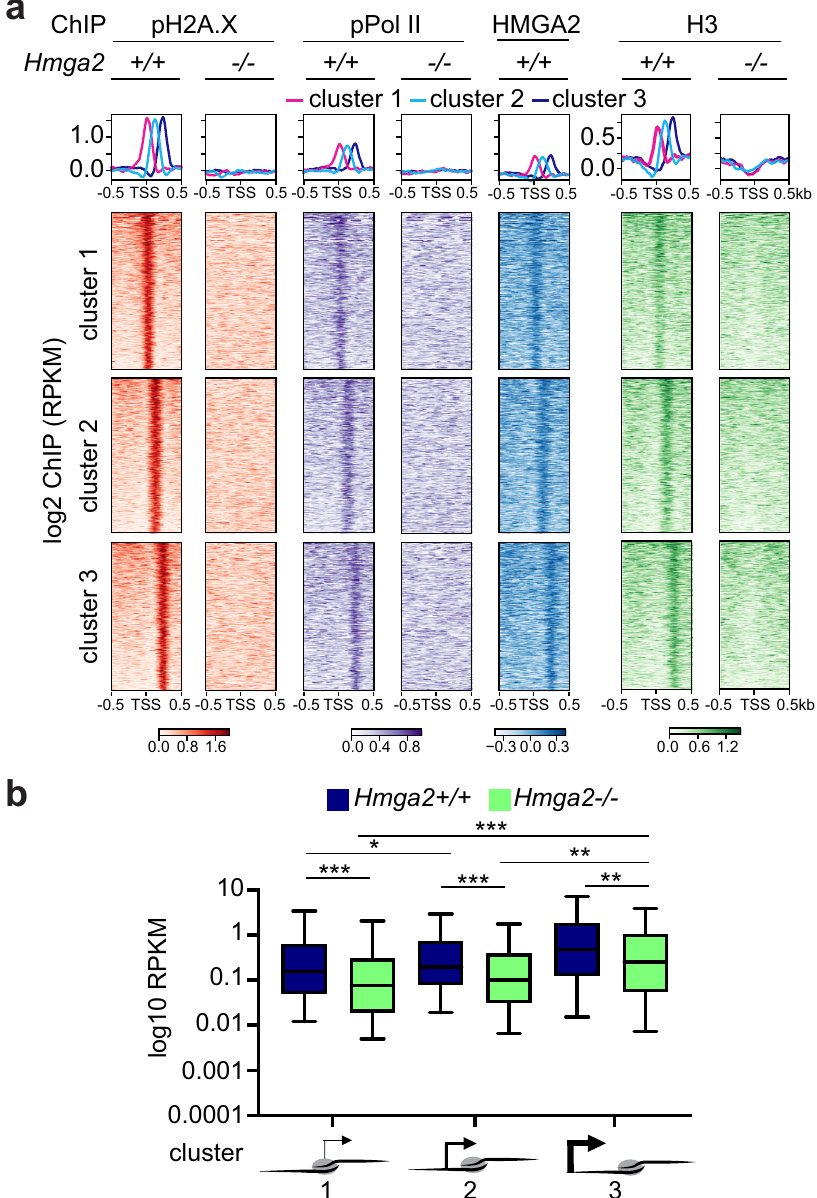
Fig. 3 Position of fi rst nucleosome containing pH2A.X correlates with RNA polymerase II and basal transcription activity in Hmga2-dependent manner. a Aggregate plots (top) and heat maps (bottom) for pPol II, pH2A.X, HMGA2 and H3 enrichment at the TSS ± ≥ kb of the top 15% candidates in Hmga2 + / + and Hmga2 − / − MEF. Three clusters were generated using k -means algorithm. Genes were sorted based on the enrichment of pH2A.X in Hmga2 + / + MEF. b Box plot representing the basal transcription activity (as log2 RPKM) of genes in Hmga2 + / + and Hmga2 − / − MEF. The genes were sorted in three groups based on the position of the fi rst pH2A.X-containing nucleosome 5´ to the TSS. Box plots indicate median (middle line), 25th, 75th percentile (box) and 5th and 95th percentile (whiskers); n = 154 genes in position cluster 1; n = 132 genes in position cluster 2; n = 134 genes in position cluster 3; asterisks, P- values after one-tailed Wilcoxon – Mann – Whitney test, *** P ≤ 0.001; ** P ≤ 0.01; * P ≤ 0.05. See also Supplementary Figs. 1 and 2. Source data are provided as a Source Data fi les 01 and